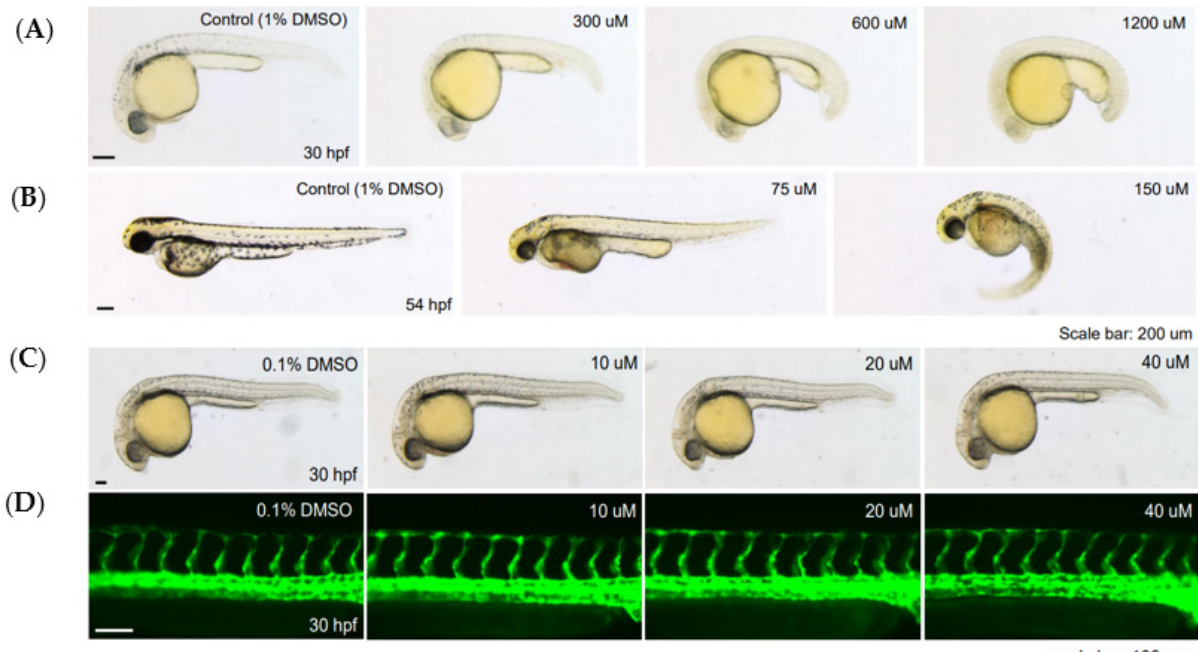
Figure 6. Morphological features of zebrafish embryos at different developmental stages. ( A ) At 30 hpf after a 24-h exposure to analogue 9 at concentrations of 300, 600, and 1200 µM, ( B ) at 54 hpf after a 48-h exposure to analogue 9 at concentrations of 75 and 150 µM, as well as ( C ) at 30 hpf after a 24-h exposure to analogue 9 at concentrations of 10, 20, and 40 µM. ( D ) Effects of analogue 9 at concentrations 10, 20, and 40 µM on blood vessel development in transgenic zebrafish, Tg ( kdrl:egfp ) at 30 hpf, same embryos as in ( C ). Vasculogenesis and angiogenesis in the trunk region were normal in both the control and analogue 9 -treated zebrafish.